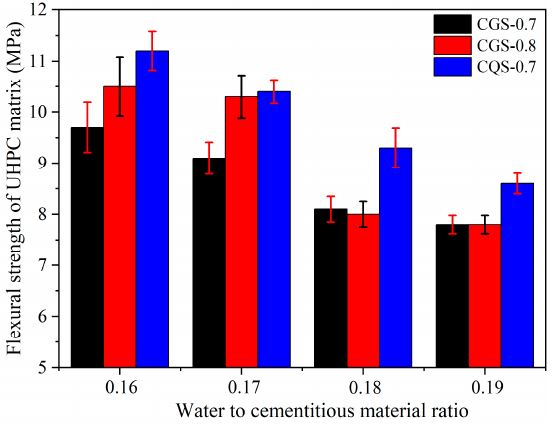
Figure 6. The flexural strength of the UHPC matrix.